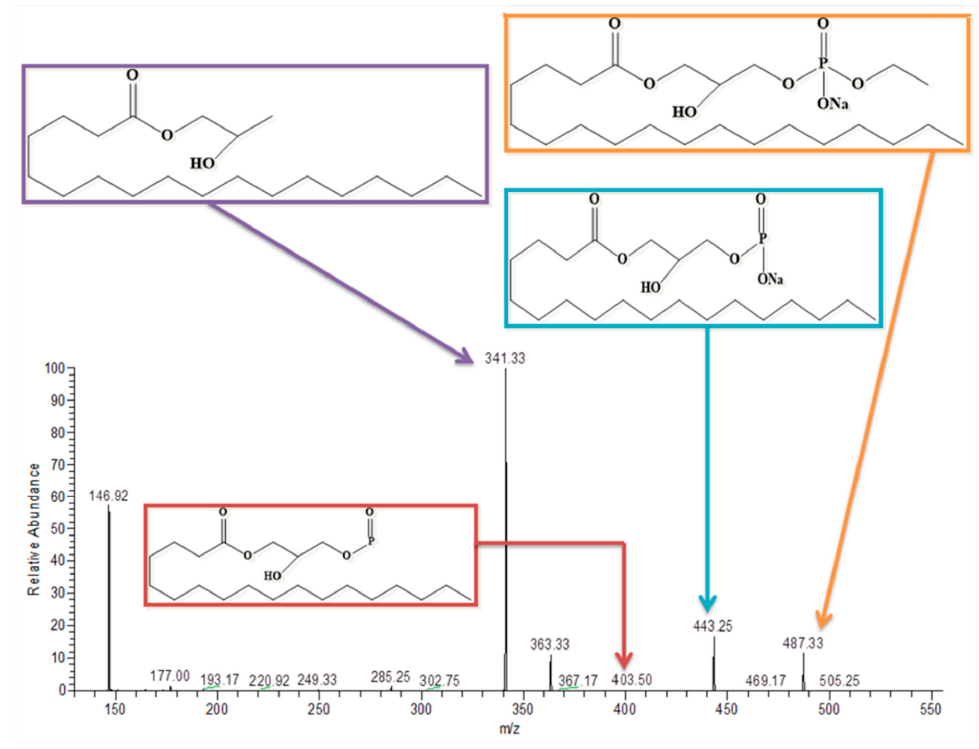
Figure 9. MS 2 of Lysophosphatidylcholine.